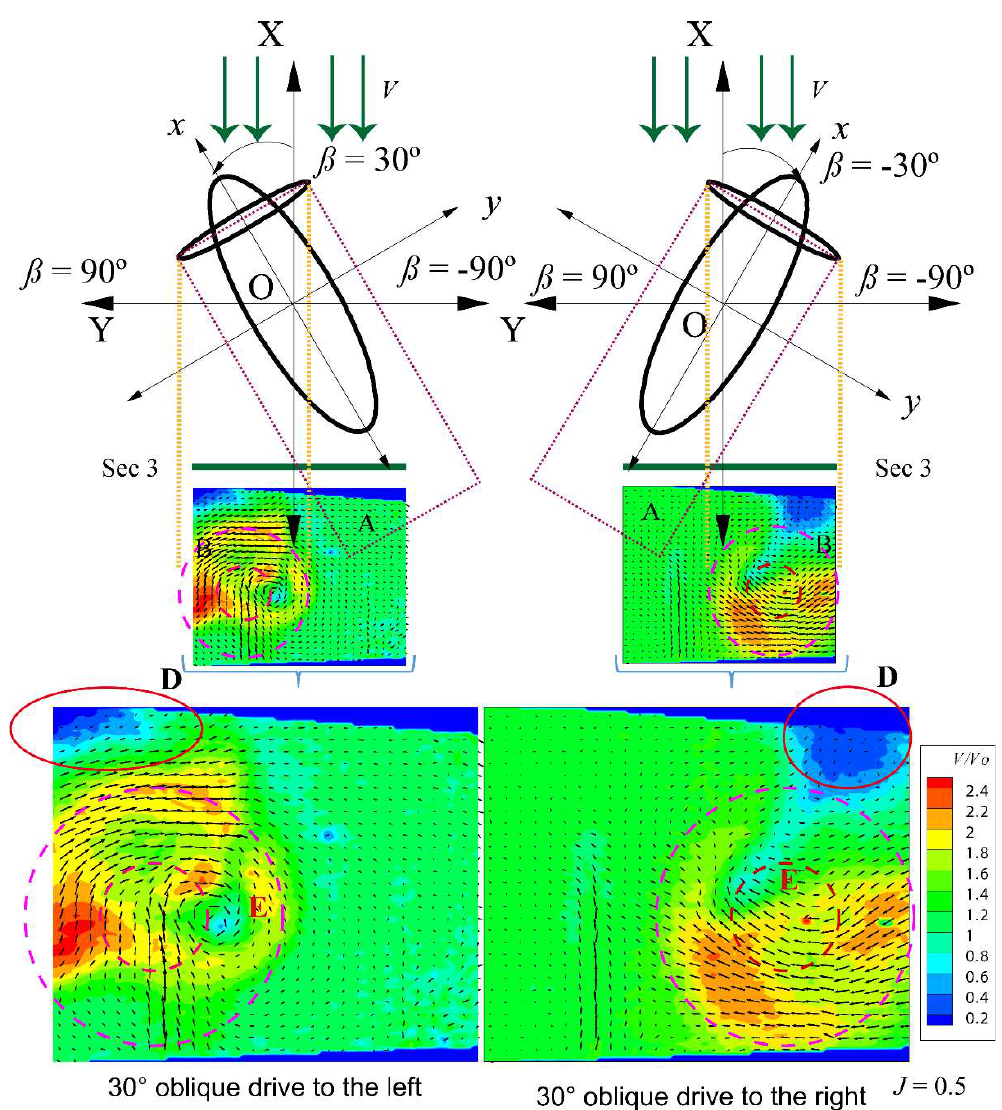
◦ oblique drive conditions ( J =